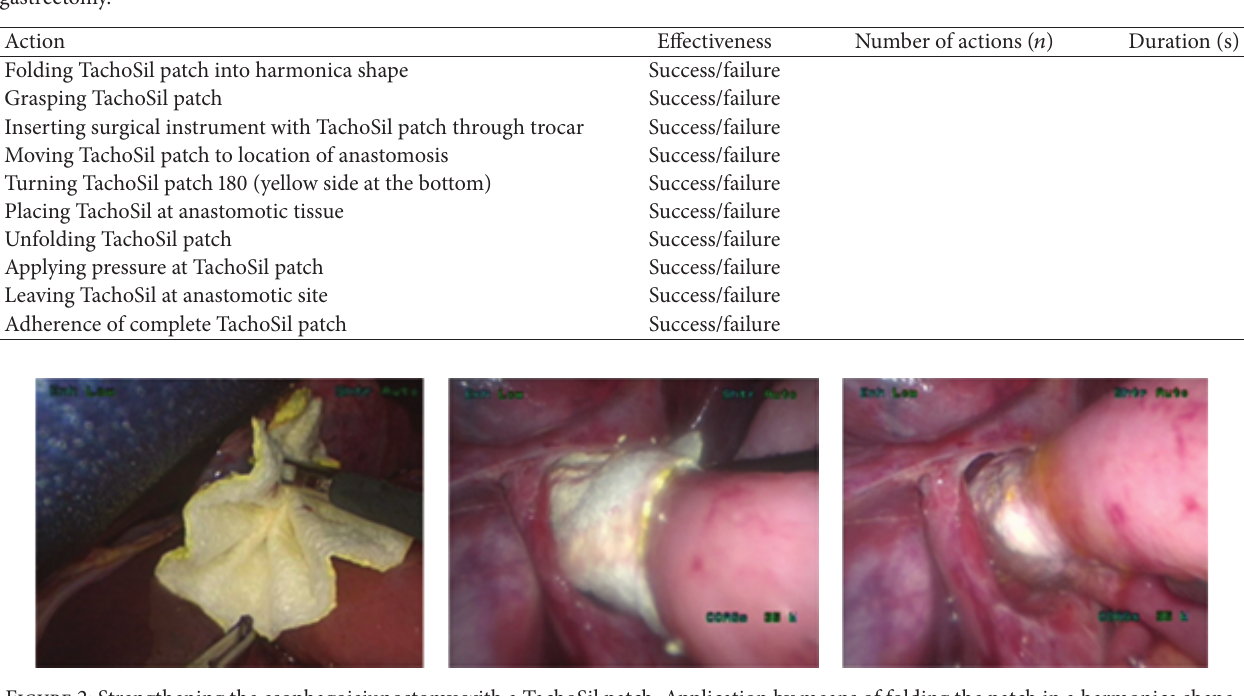
by gently pulling either side of the patch. The patch was slowly advanced over the anastomosis and wrapped around it. To ensure adhesion, pressure was applied to the patch. No learn- ing curve was found for TachSil application in these